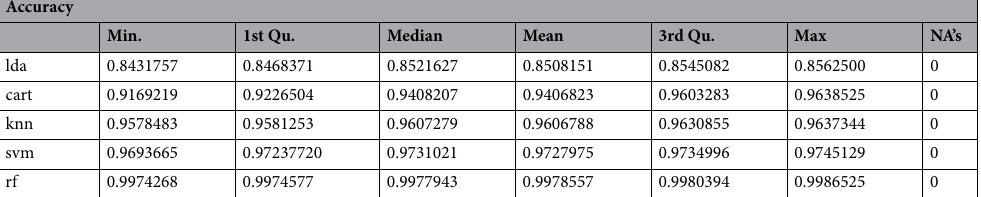
Table 1. Accuracy of ML algorithms after 30-fold cross-validation. The minimum (min), 1st quartile (1st Qu.), median, mean, 3rd quartile (3rd Qu.), maximum (max) are calculated for each machine learning algorithm tested on the oncosomatic variant dataset. 1st Qu. is the median (the middle) of the lower half of the data, approximately 25% of the numbers in the dataset lie below 1st Qu and 75% lie above the 1st Qu. The 3rd Qu. is the median (the middle) of the upper half of the data, about 75% of the numbers in the dataset lie below 3rd Qu. and approximately 25% lie above the 3rd Qu.